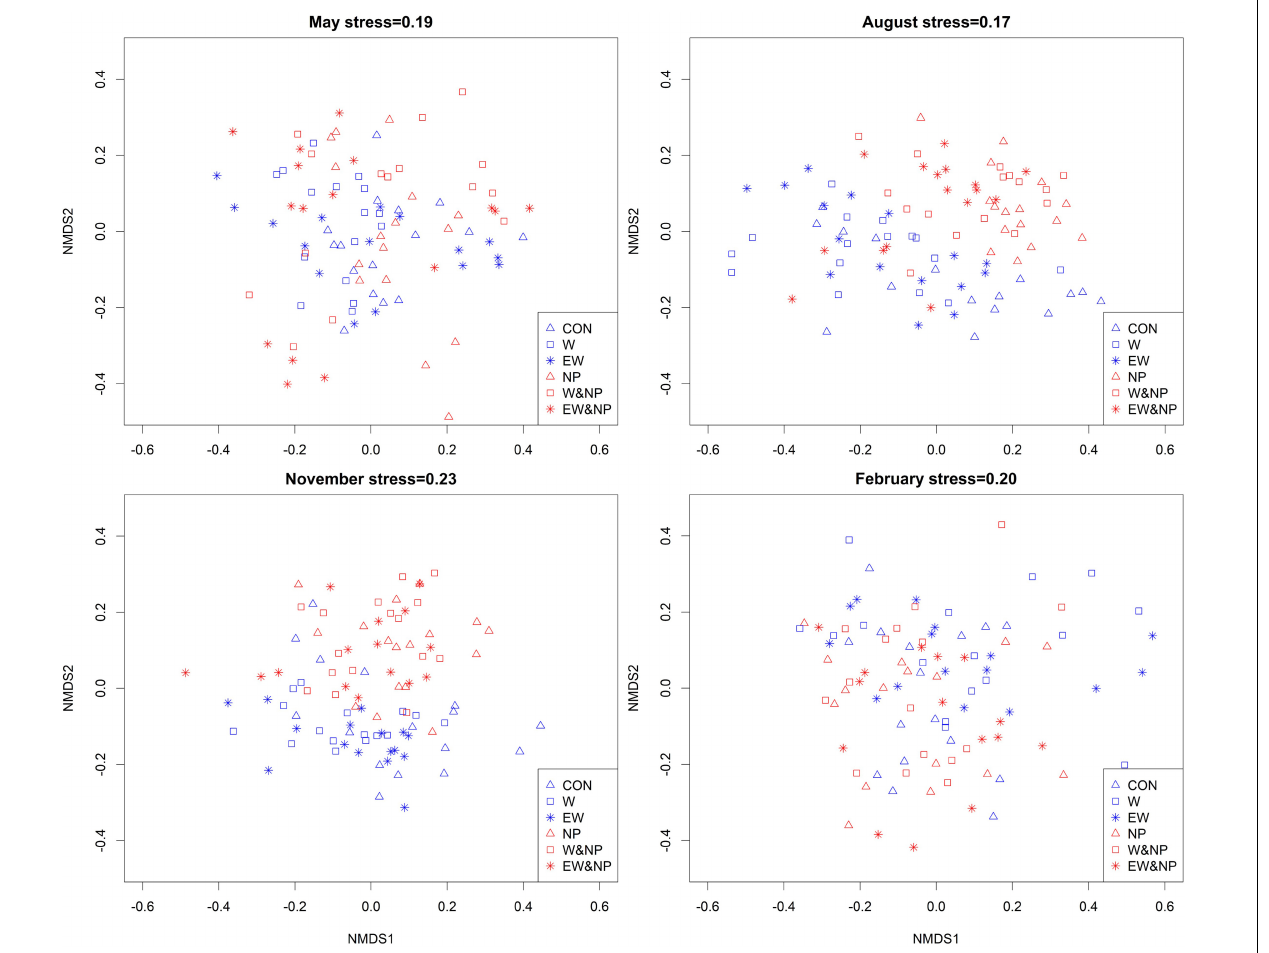
FIGURE 4 | Non-metric multidimensional scaling (NMDS) plots of periphyton communities in six treatments based on Bray–Curtis similarities calculated from genus density (square-root